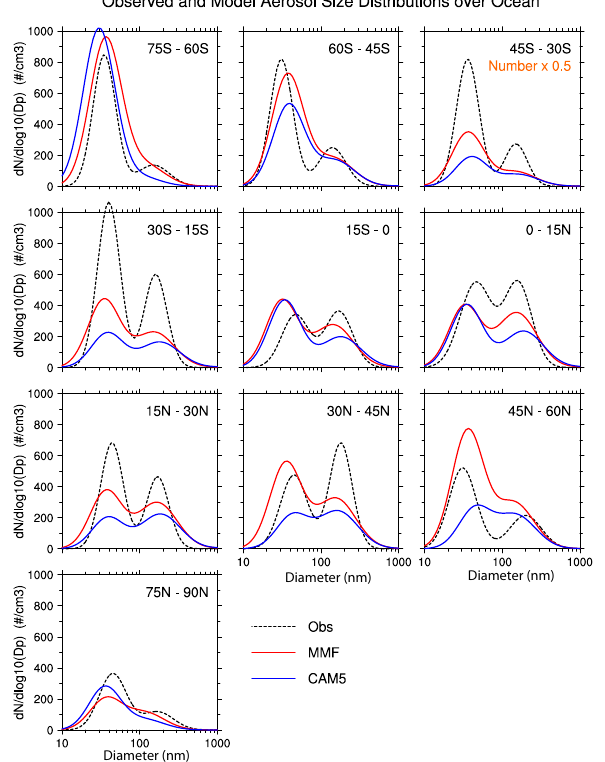
Figure 07 Fig. 7. PD aerosol size distributions in the marine boundary layer from the MMF, CAM5, and observations. Observations (Obs) are from Heintzenberg et al. (2000). For the 45 ◦ S–30 ◦ S latitude band, aerosol number density is scaled by 0.5 so the same y axis can be used for all latitude bands.